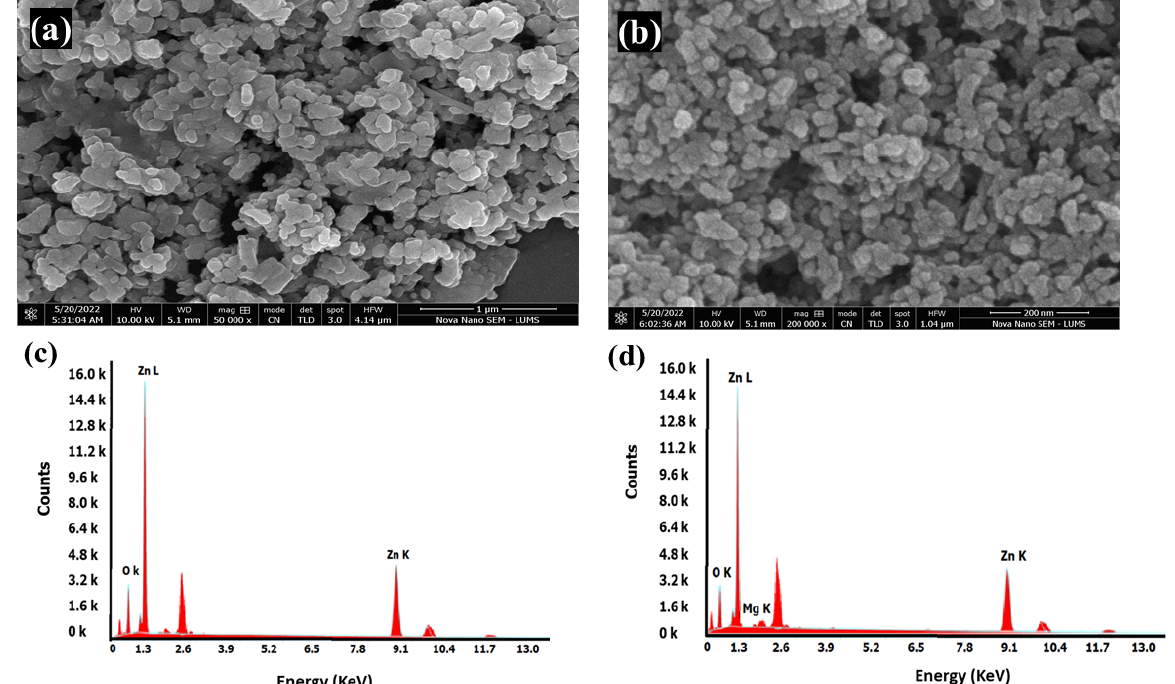
Figure 2. ( a ) SEM of Bare ZnO NPs, ( b ) SEM of Mg-doped ZnO, ( c ) EDX of Bare ZnO NPs, and ( d ) EDX of Mg-doped ZnO NPs.